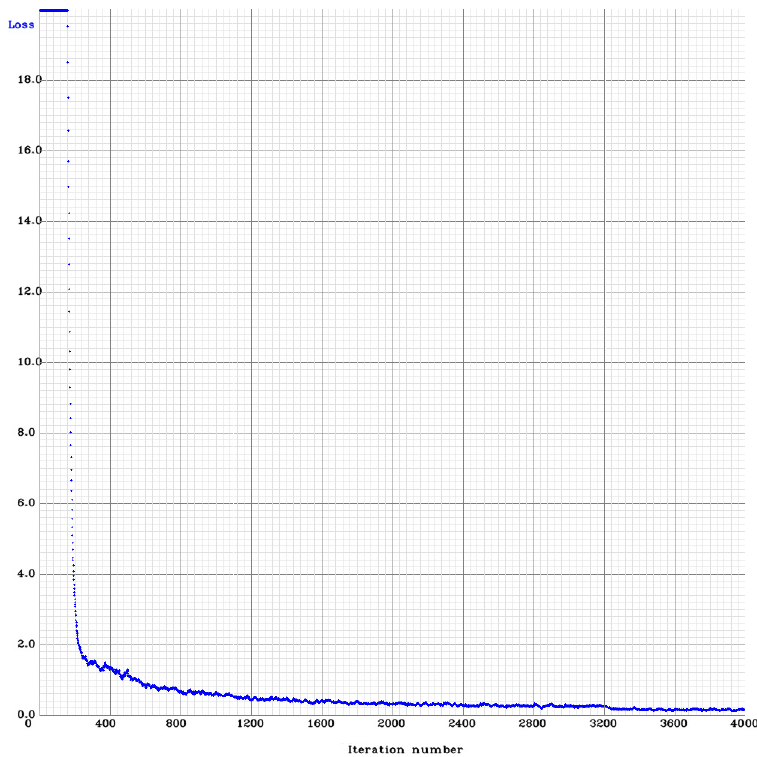
Figure 8. Training loss of the YOLO V4-Tiny model after 4000 iteration steps. Table 1. The target detection performance evaluation results with the index intersection over union (IoU), average precision (AP), mean average precision (mAP), and recall.